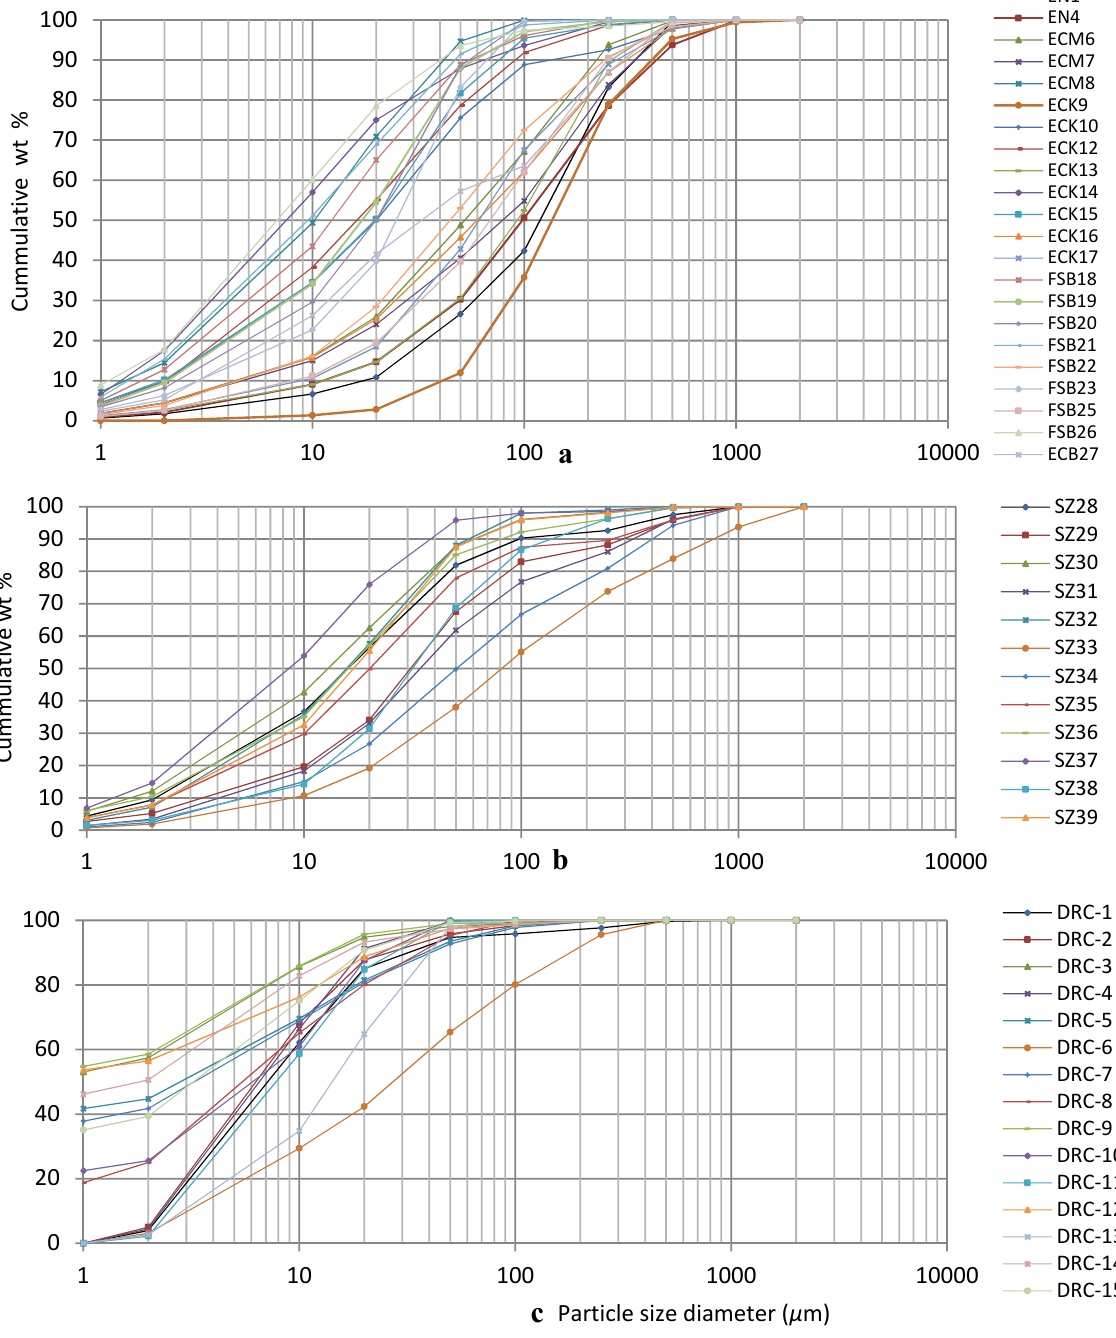
Figure 2. Particle size distribution curve of geophagic samples from South Africa ( a ), Swaziland ( b ), and DRC ( c